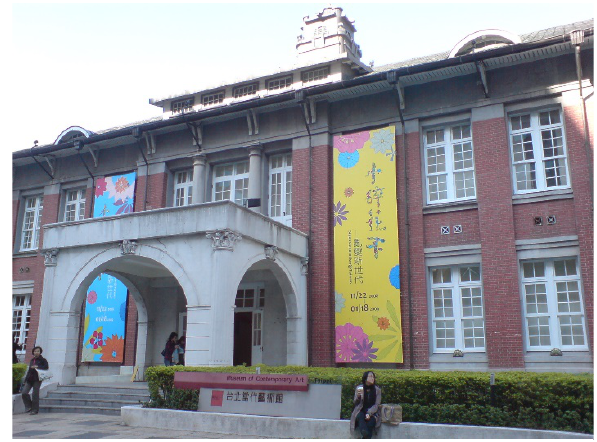
Figure 6: the Taipei City Museum of Contemporary Arts.